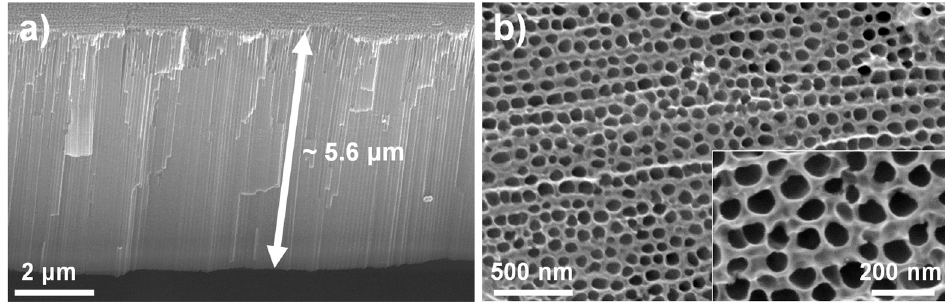
Figure 3. SEM images of ( a ) cross-section and ( b ) top-view of bare TiO 2 nanotubes (inset: magnified top-view